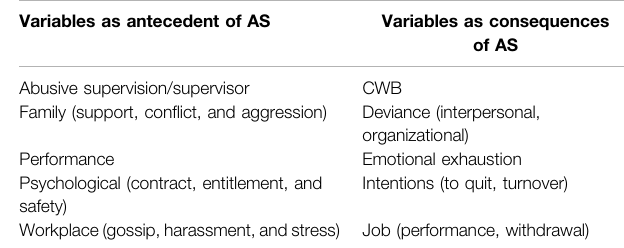
TABLE 1 | Most frequent variables identi fi ed as antecedents and consequences of AS.